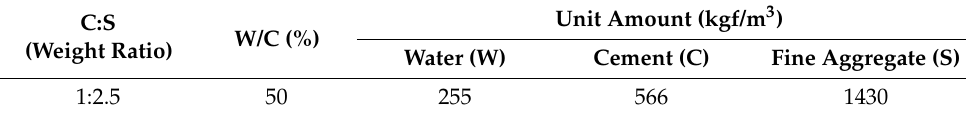
Table 3. Mortar specimen mix proportions.